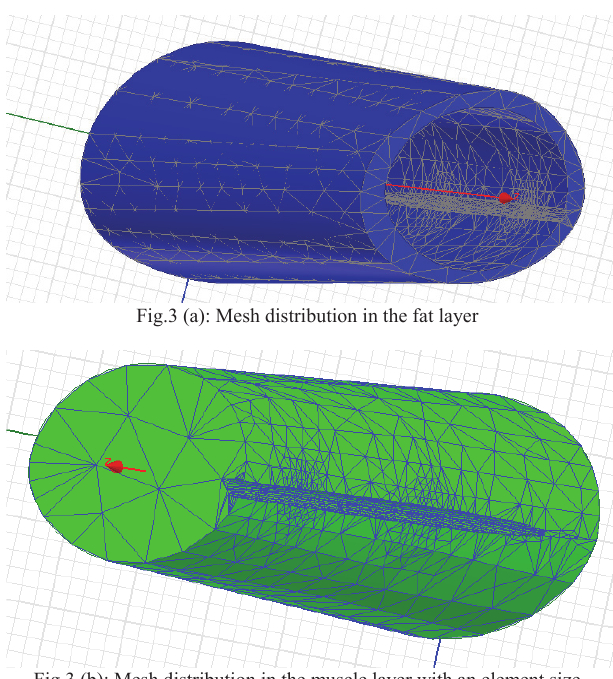
Fig.3 (b): Mesh distribution in the muscle layer with an element size of 10 mm